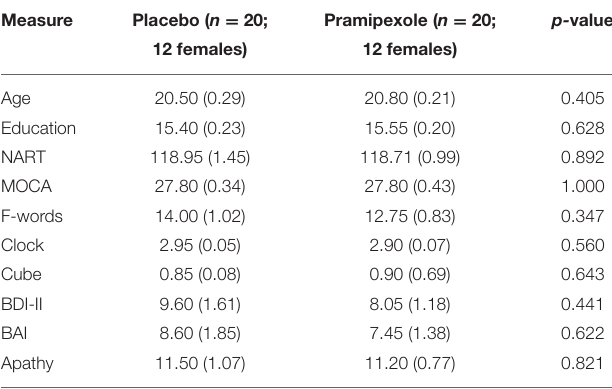
TABLE 1 | Demographic, cognitive, and affective measures for pramipexole and placebo groups.